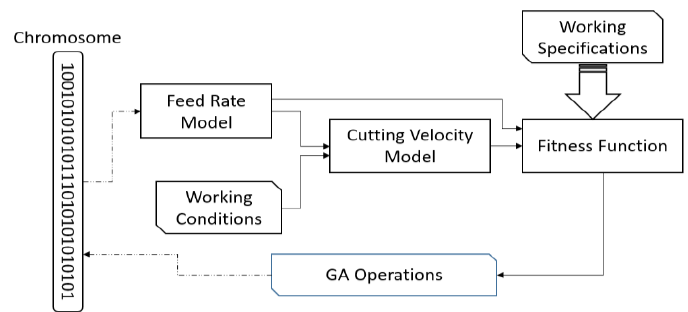
Figure 6. GA (genetic algorithm) working scheme.